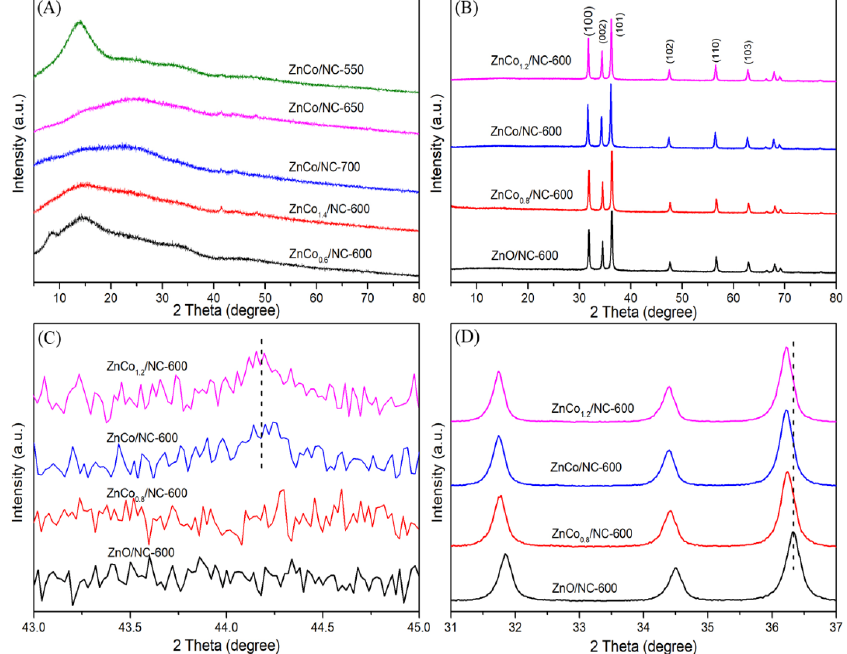
Figure 1. XRD patterns of: ( A ) catalysts with amorphous structure; ( B ) catalysts with crystalline structure. Local enlargement of XRD patterns: ( C ) 43–45°, ( D ) 31–37°.